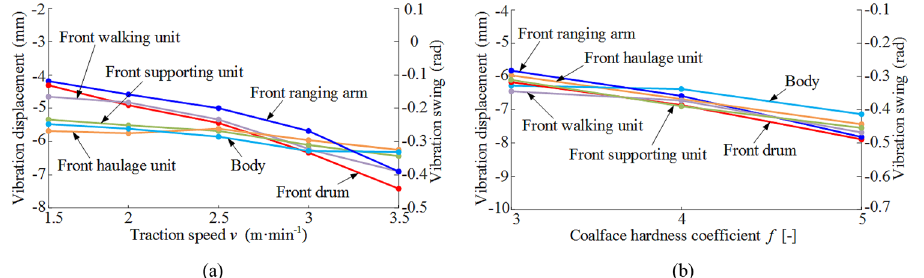
Figure 10. Vibration displacement of key coal shearer components under slant-cutting conditions with different operating parameters: ( a ) different traction speed, ( b ) different coalface hardness coefficient.